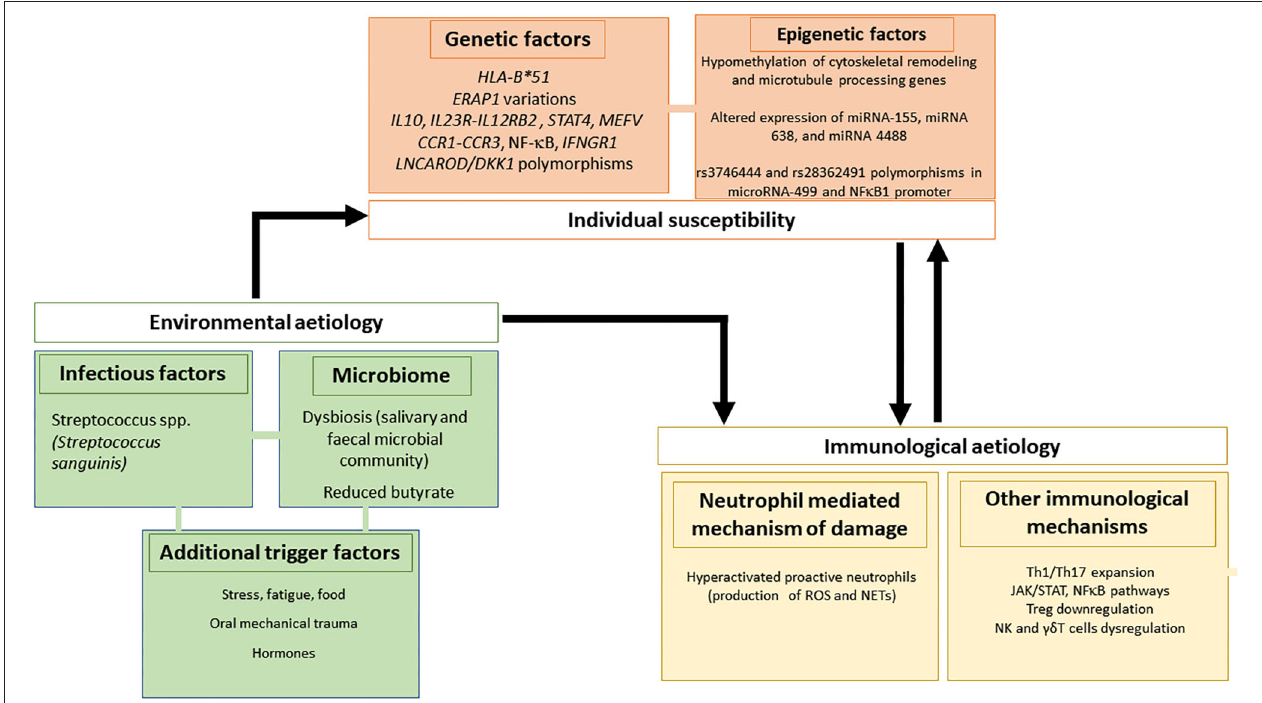
FIGURE 2 | Genetic/epigenetic, infectious and immunological factors involved in the pathogenesis of Behçet’s syndrome.